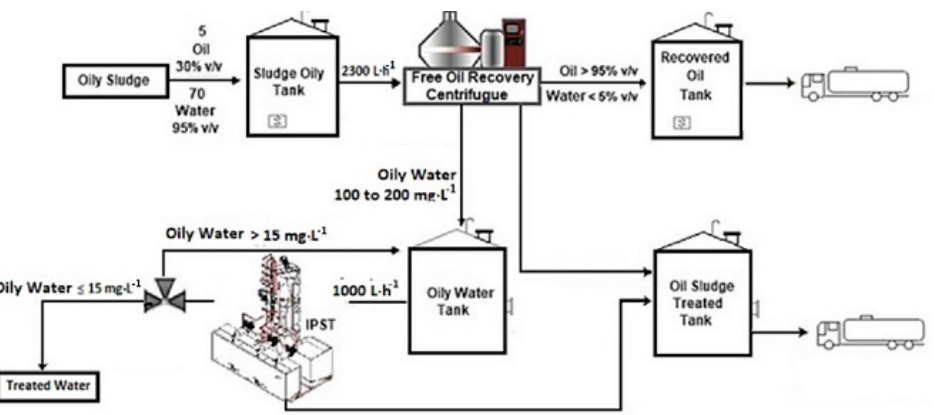
Figure 7. IPST flowchart downstream of a free oil recovery centrifuge in an industrial sector for the treatment of oily effluents.